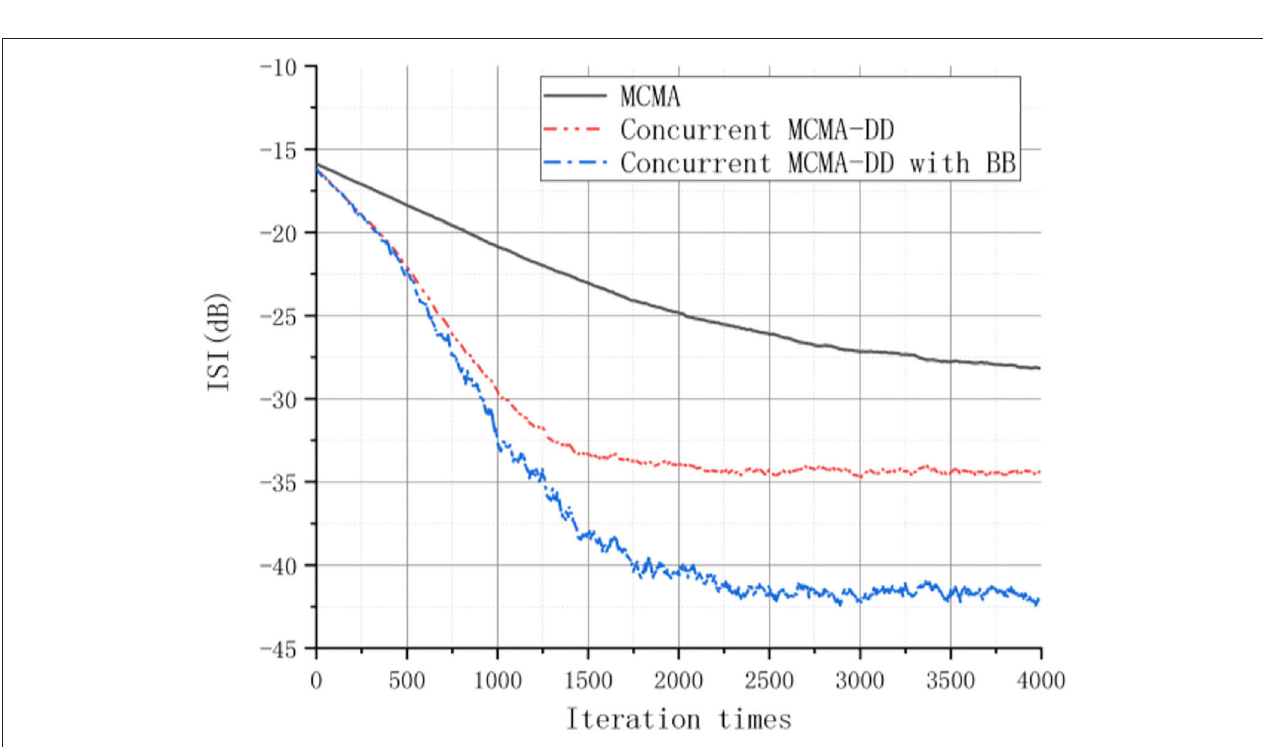
FIGURE 5 | The ISI performance of the three